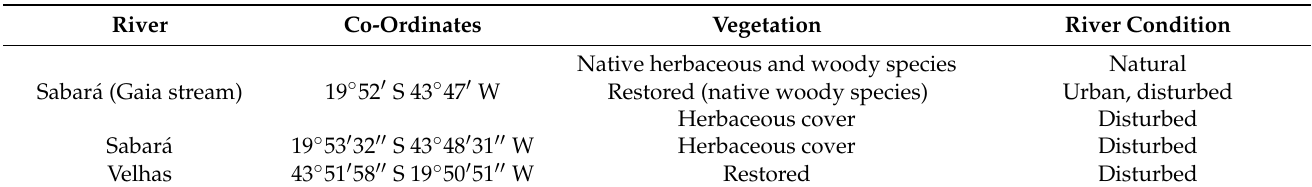
Table 1. Vegetation and some characteristics of the riparian sites under study at Velhas River and its tributaries.